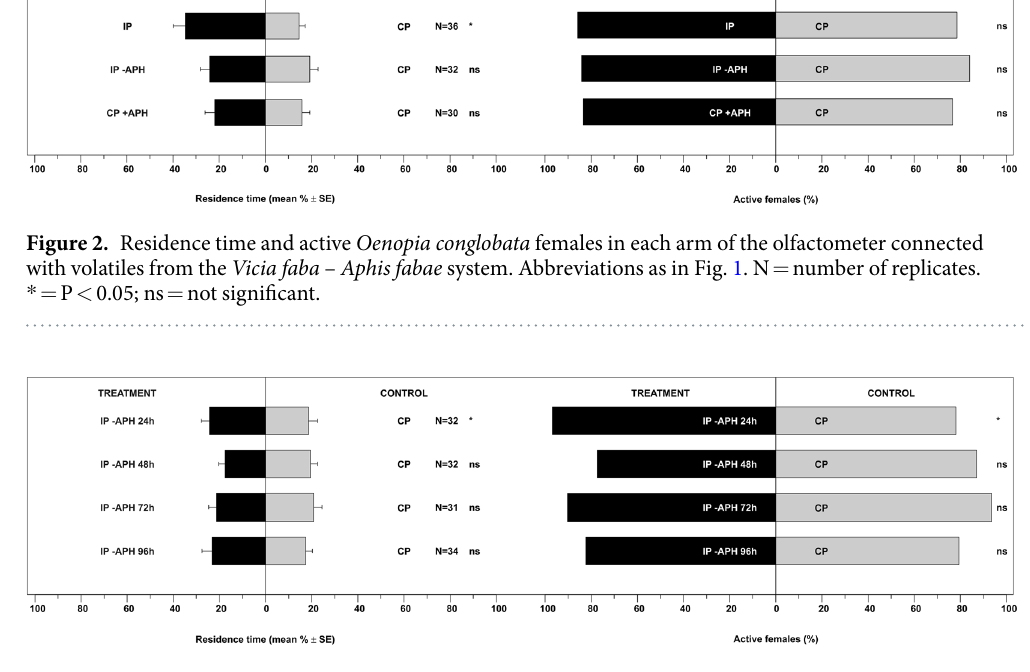
Figure 3. Residence time and active Harmonia axyridis females in each arm of the olfactometer connected with volatiles from the Vicia faba – Aphis fabae system. Odour treatments consisted of a V. faba plant infested with A. fabae colonies but with aphids carefully removed at 24 (IP -APH 24 h), 48 (IP -APH 48 h), 72 (IP -APH 72 h) or 96 (IP -APH 96 h) hours prior to the bioassay. Control consisted of a clean V. faba plant (CP). N = number of replicates. * = P < 0.05; ns = not